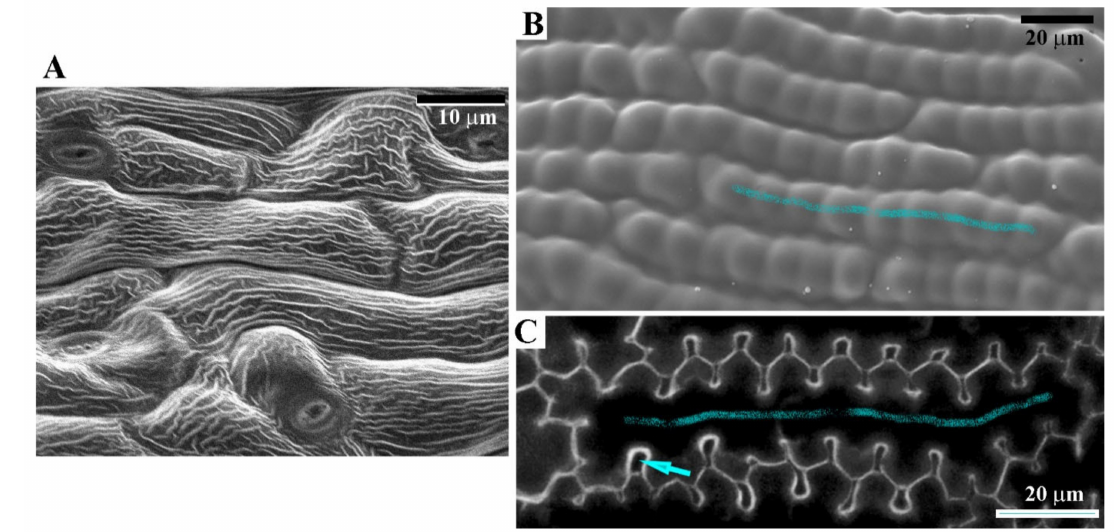
Figure 2. Epidermis of arabidopsis sepal ( A ) and pimpernel ( Anagallis grandiflora ) petal ( B , C ). ( A ) Micrograph of the abaxial surface of the mature arabidopsis sepal obtained using scanning electron microscopy. Note cuticular ridges which are formed by folds of the cuticle proper, shown in Figure 1A. ( B,C ) Petal epidermis of pimpernel. ( B ) Micrograph of the mature petal surface obtained using scanning electron microscopy. An exemplary cell is marked by a blue line. Note numerous papillae on individual cells. The papillate outer periclinal walls are covered with a continuous cuticle layer. ( C ) Anticlinal cell walls are shown in the optical section through these walls obtained using confocal laser scanning microscopy. An exemplary cell is marked by a blue line. Note numerous intercalary gas spaces at contacts between adjacent cells (arrow points to an exemplary space). In ( B ), the intercalary spaces are not visible because they are covered by a continuous